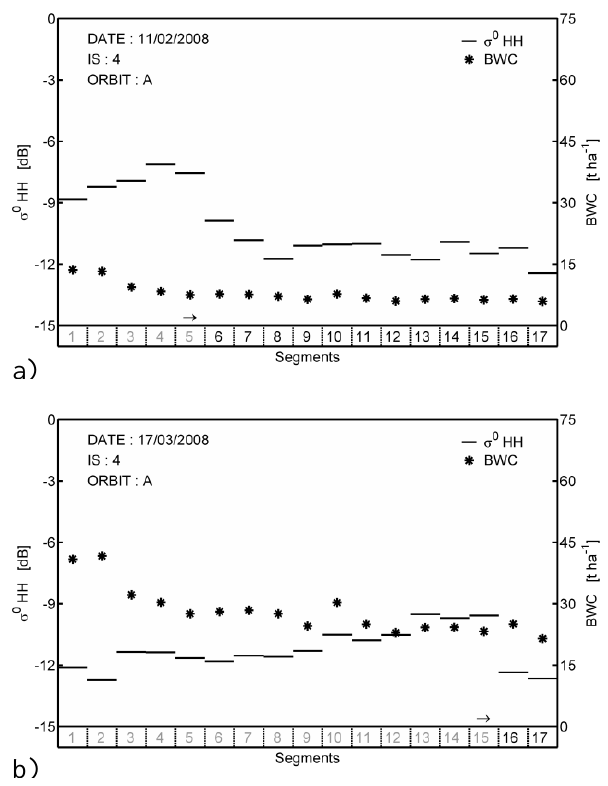
Fig. 5. Spatial variations of backscattering coefficient and biomass water content over the different segments of the largest wheat field on two dates: a) 11/02/08, first irrigation time, b) 17/03/08, second irrigation time. The irrigation status is indicated (grey: irrigated, black: non irrigated), the arrow indicates the direction of the irrigation-watercourse.